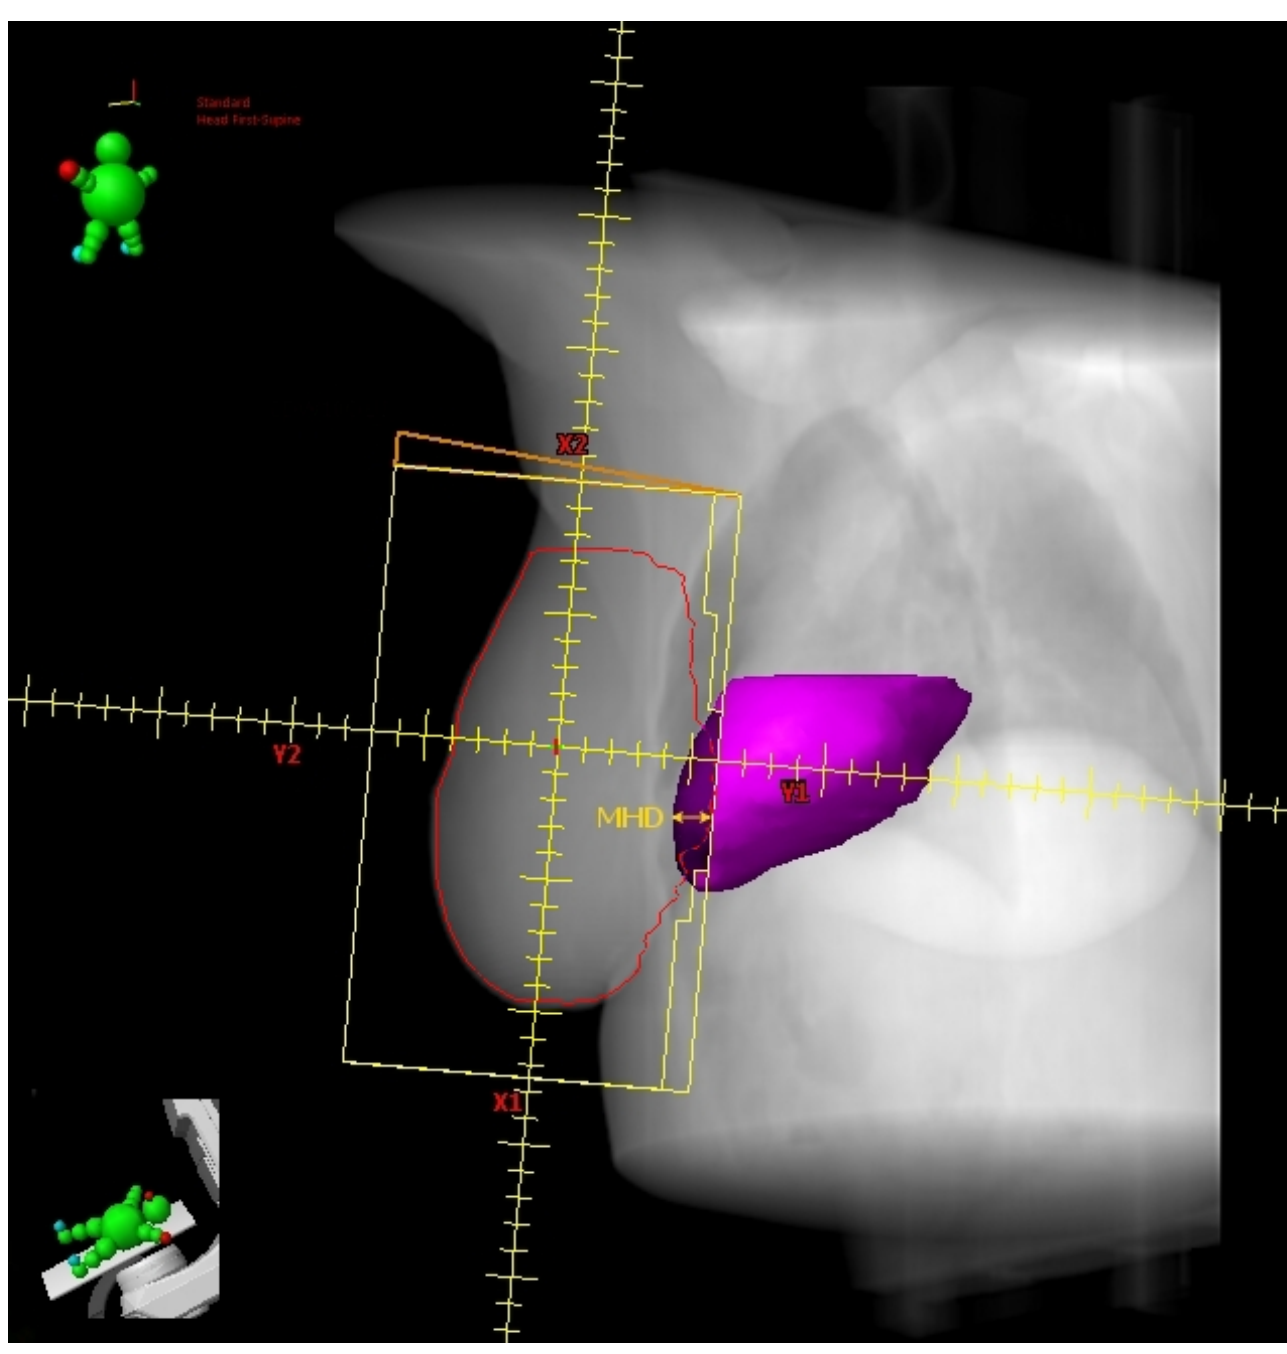
Figure 3. Digitally reconstructed radiograph (DRR) with external tangential beam’s-eye-view. The heart volume in field (HVIF, dark magenta) and the maximum heart depth (MHD) have been highlighted.